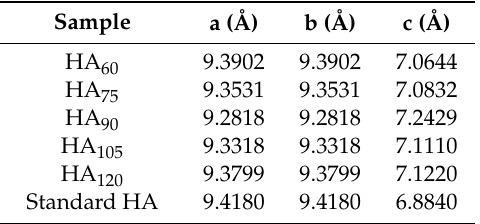
Table 3. Calculated cell parameters of HA crystals obtained at different deposition time.